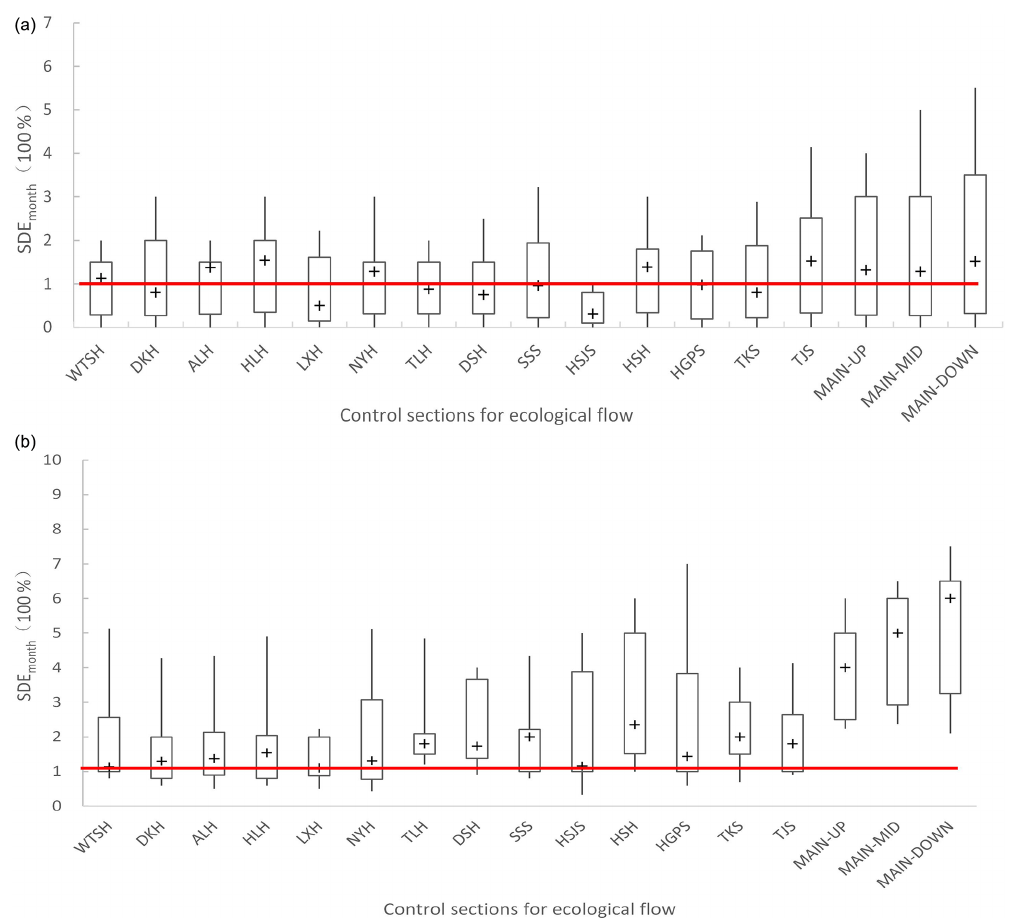
Figure 7. Different SDE month of each section before (a) and after (b) implementing the recommended water replenishment scheme.